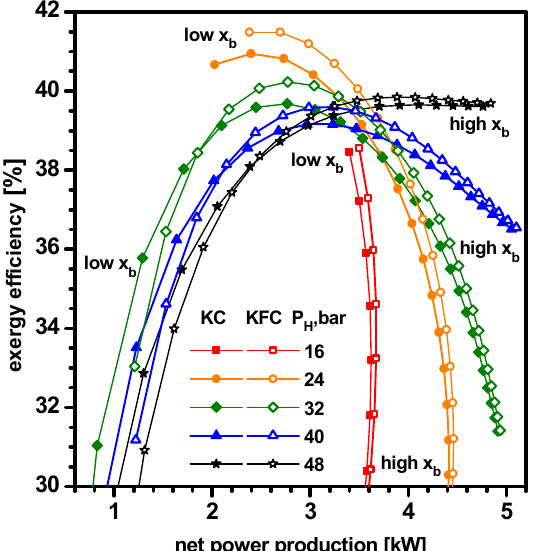
Figure 6. Diagram of net power production vs. exergy e ffi ciency of Kalina cycle (KC) and KFC.